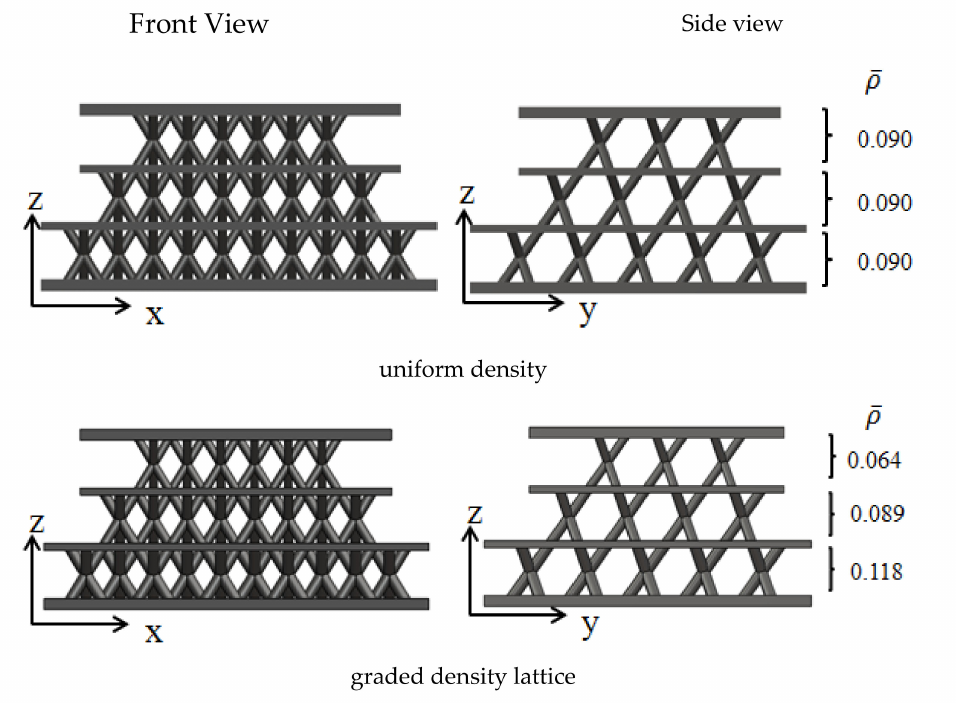
Figure 3. CAD model of uniform and graded density Kagome lattice